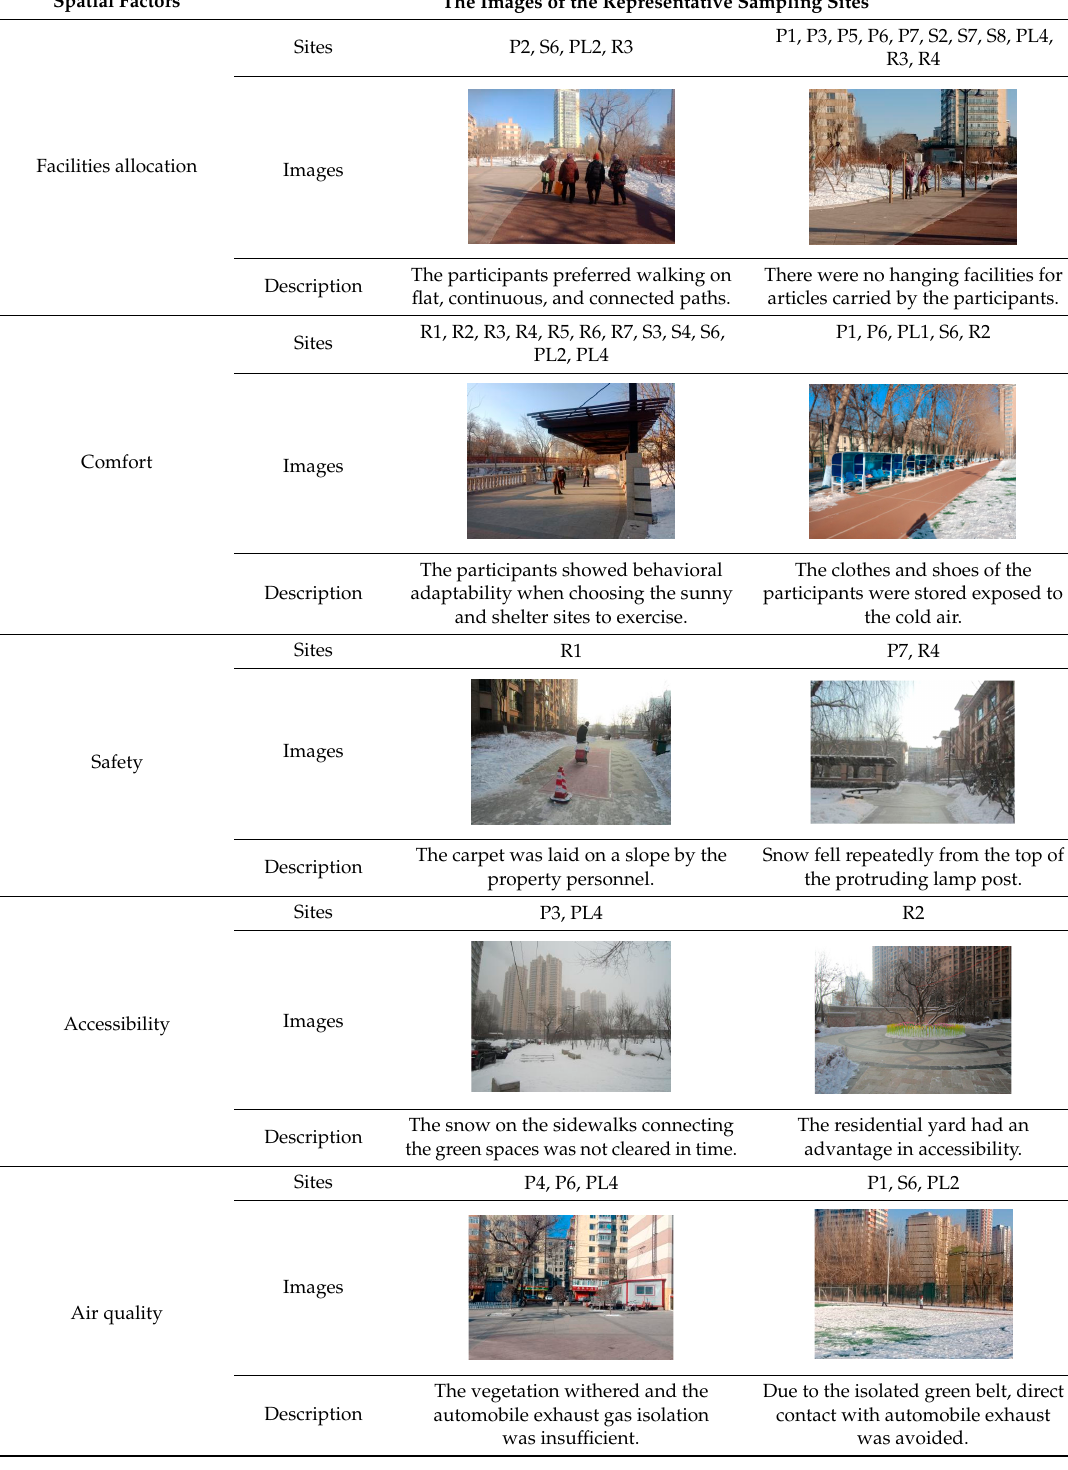
The participants preferred walking on There were no hanging facilities for flat, continuous, and connected paths. articles carried by the participants. connected paths. participants.